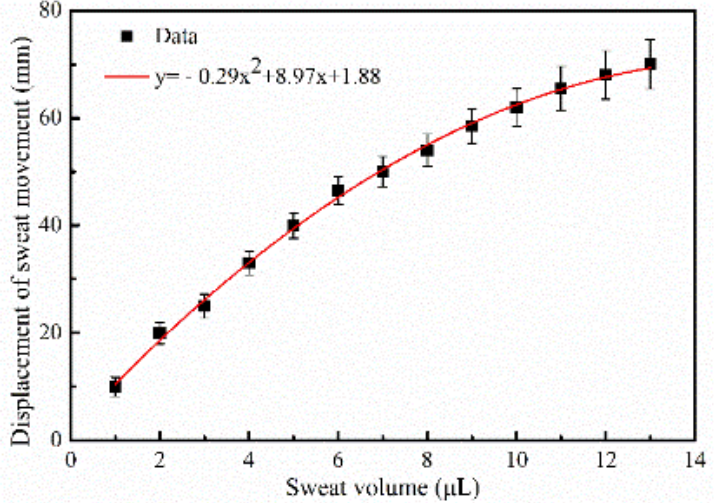
Figure 10. Second-order fitting curve for the variation in displacement with added sweat volume determined using scale lines.